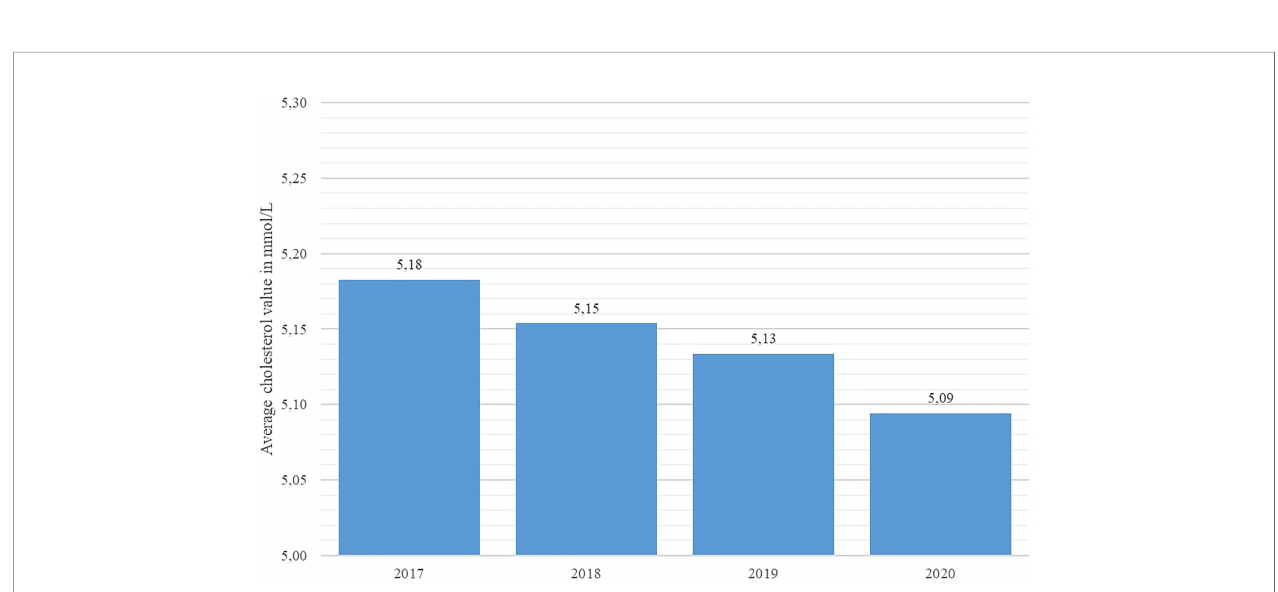
FIGURE 5 | Average total cholesterol values in diabetes patients in Croatia per year, 2017 - 2020.